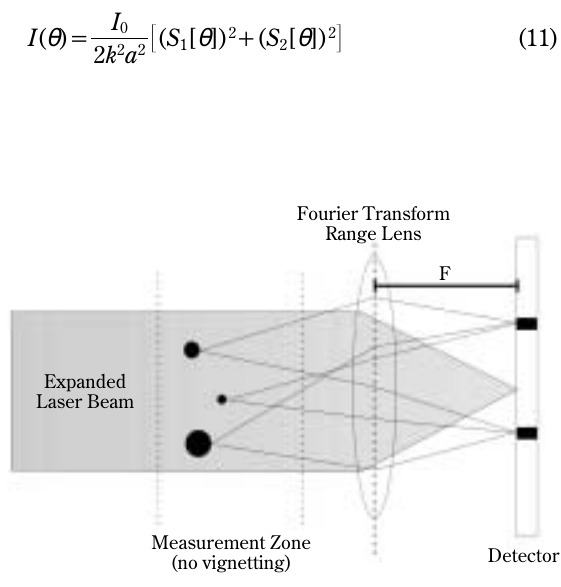
Measurement Zone (no vignetting)